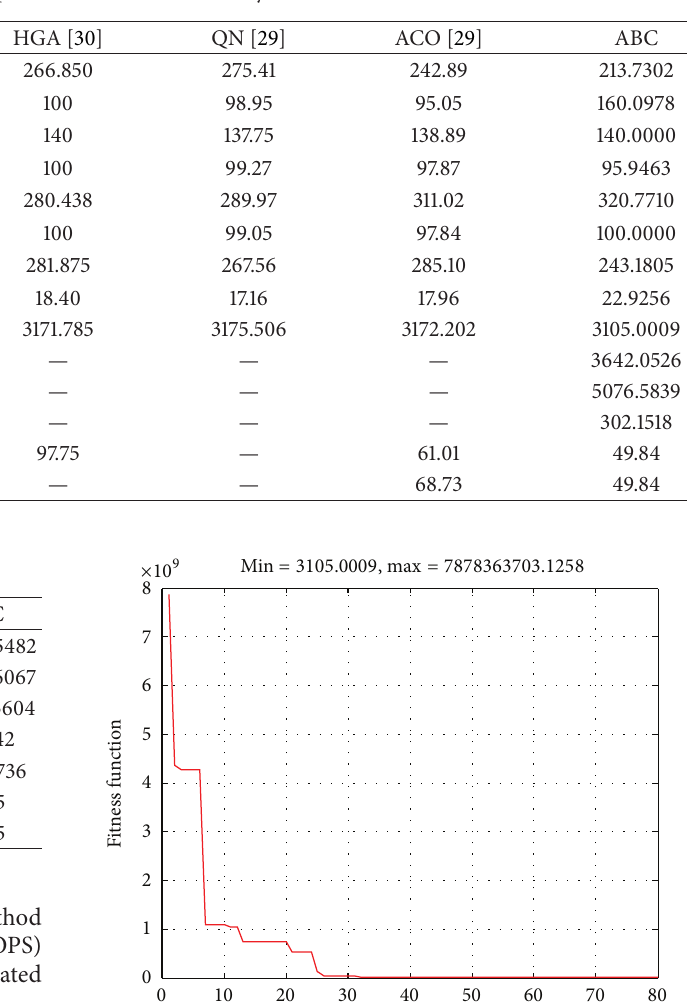
Table 3: Result comparison for the IEEE 57-bus system.